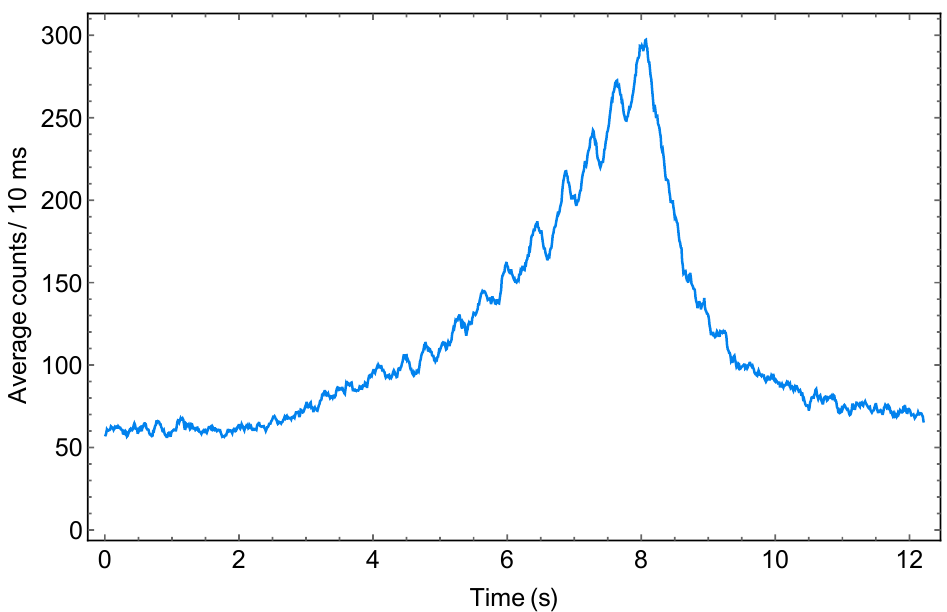
Figure 8. Average counts of photons emitted by neutral barium atoms decaying from the 5d6p 3 D 1 level are plotted as a function of time. The neutrals are emitted from one of the two ovens by applying a train of 20 current pulses 400ms long with a duty cycle of 75%, whereas the amplitude is linearly decreased from 100A to 70A to keep the temperature from exponentially rising. Time t = 0 corresponds to the moment at which the current pulses’ train